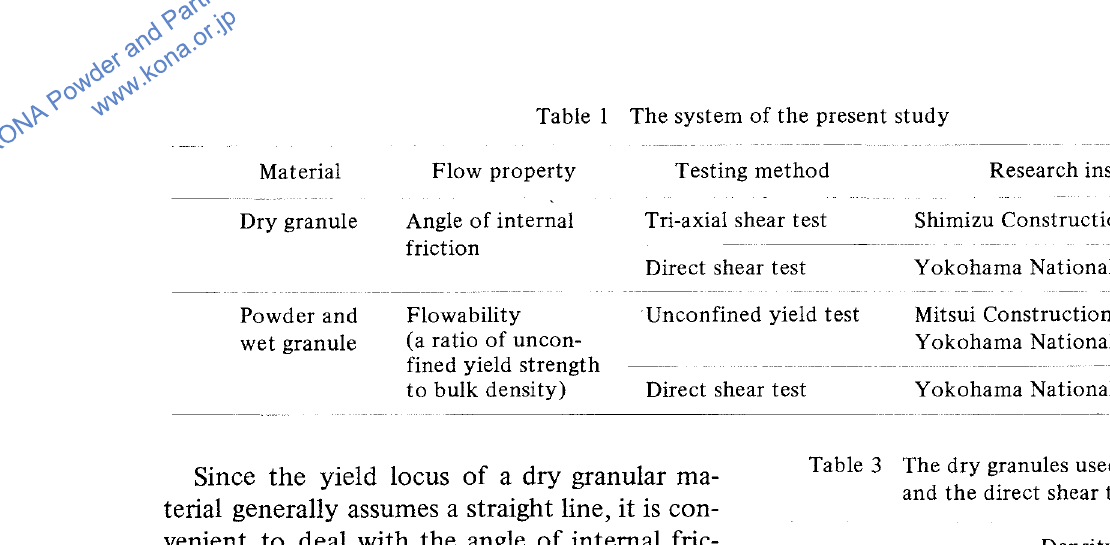
Table 3 The dry granules used in both the tri-axial and the direct shear